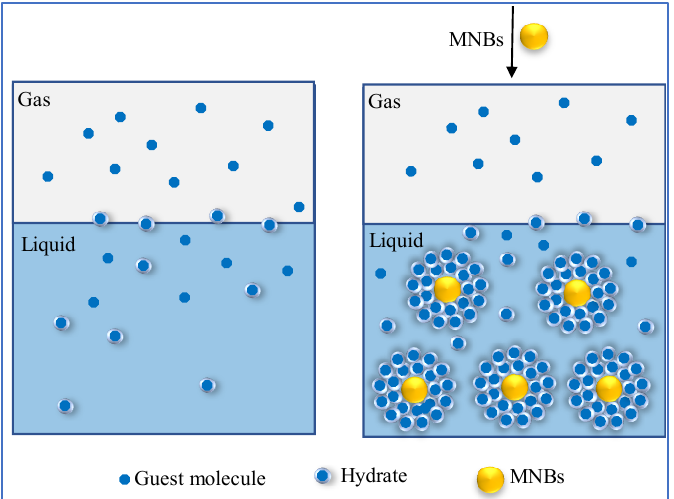
Figure 3. Diagram of how the addition of microbubbles changes the nucleation position of crystals [70]. crystals